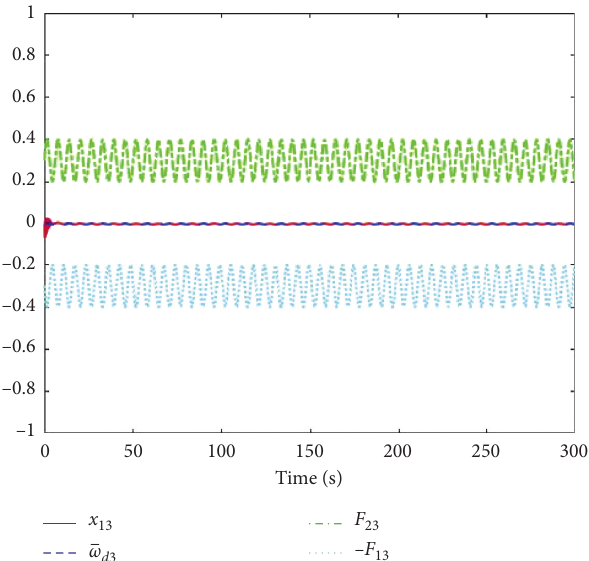
Figure 3: Trajectory of ϖ